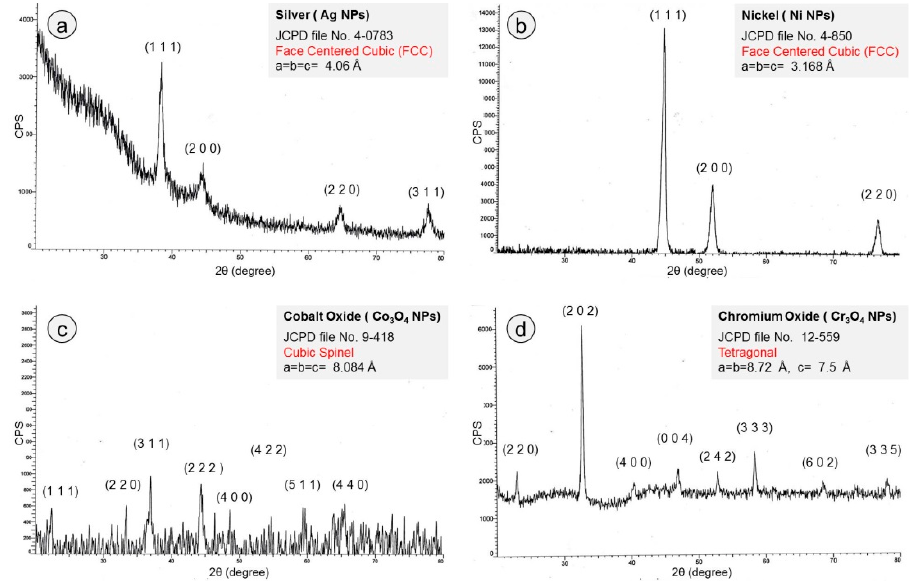
Figure 4. X-ray diffraction (XRD) spectra; ( a ) AgNPs, ( b ) NiNPs, ( c ) cobalt oxide NPs, and ( d ) chromium oxide NPs, indicating FCC crystalline metallic nature of AgNPs and NiNPs, cubic spinel crystalline structure of cobalt oxide NPs and tetragonal crystalline behavior of chromium oxide NPs.